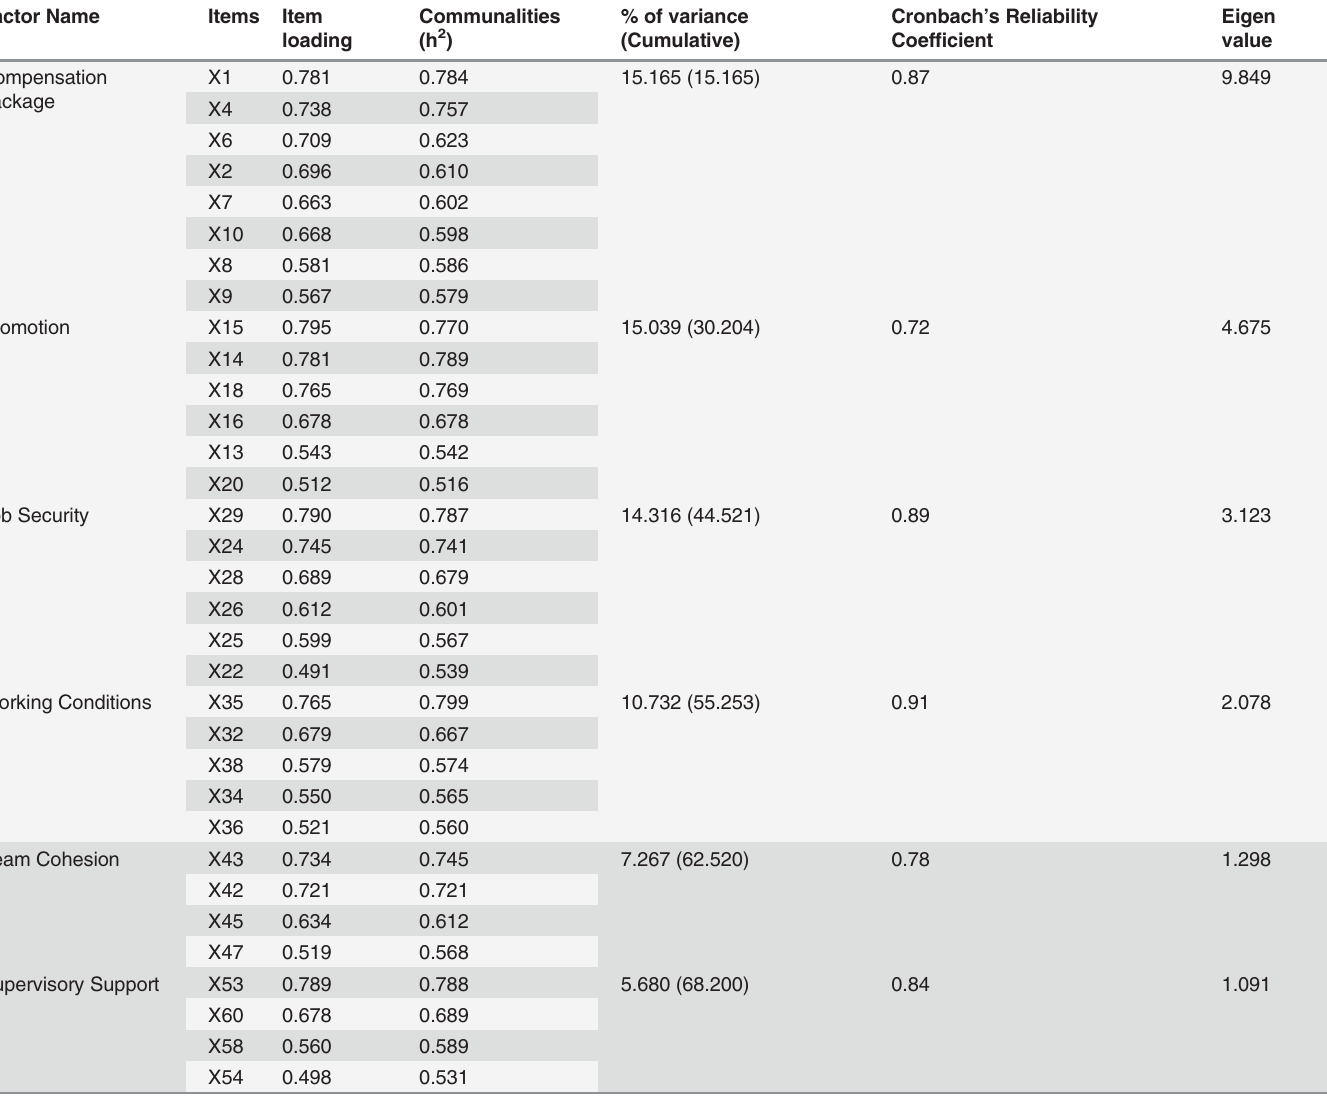
Table 1. Summary of Rotated Component Matrix, Cronbach ’ s alpha, variance and Eigen